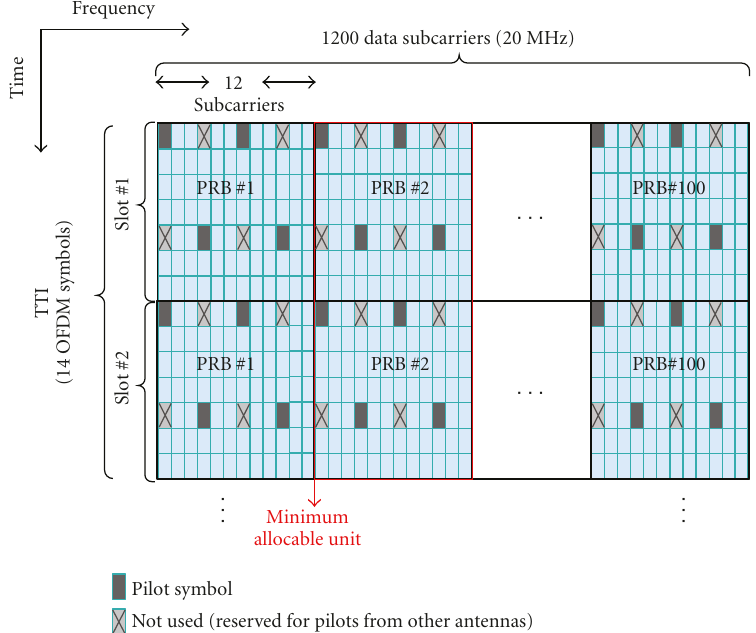
Figure 8: LTE physical resources structure.